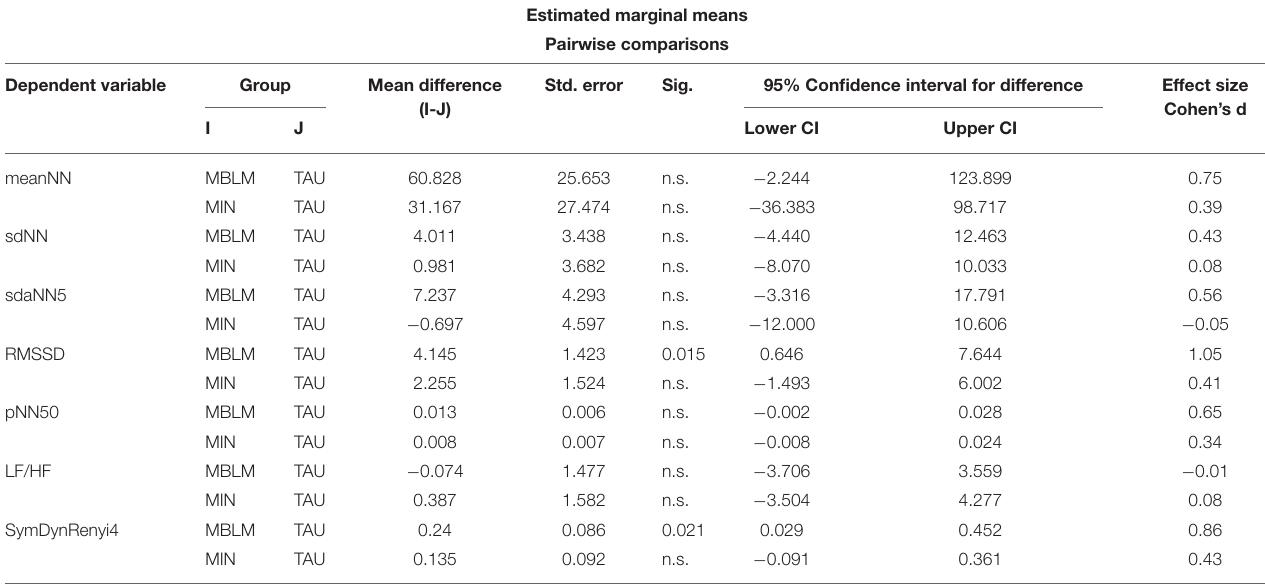
TABLE 2 | Results of the model-based estimated marginal means–pairwise comparisons between the pre-to-post differences of the three groups MBLM, MIN, and TAU. Estimated marginal means